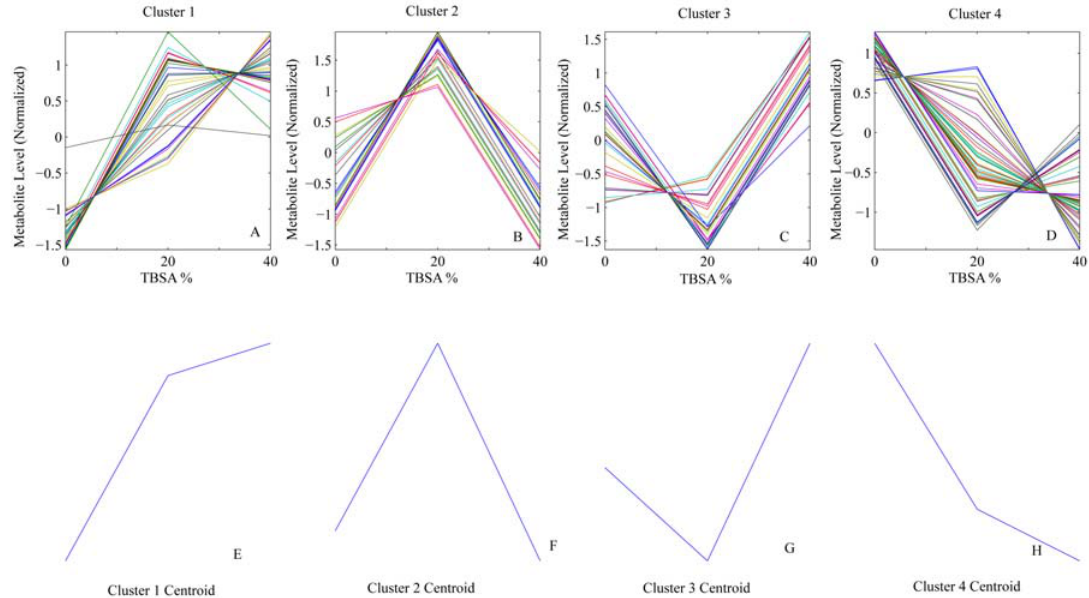
Figure 3. Identified Clusters. ( A – D ) Profile of metabolites classified within clusters 1–4. ( E – H ) Centroids (patterns) for each